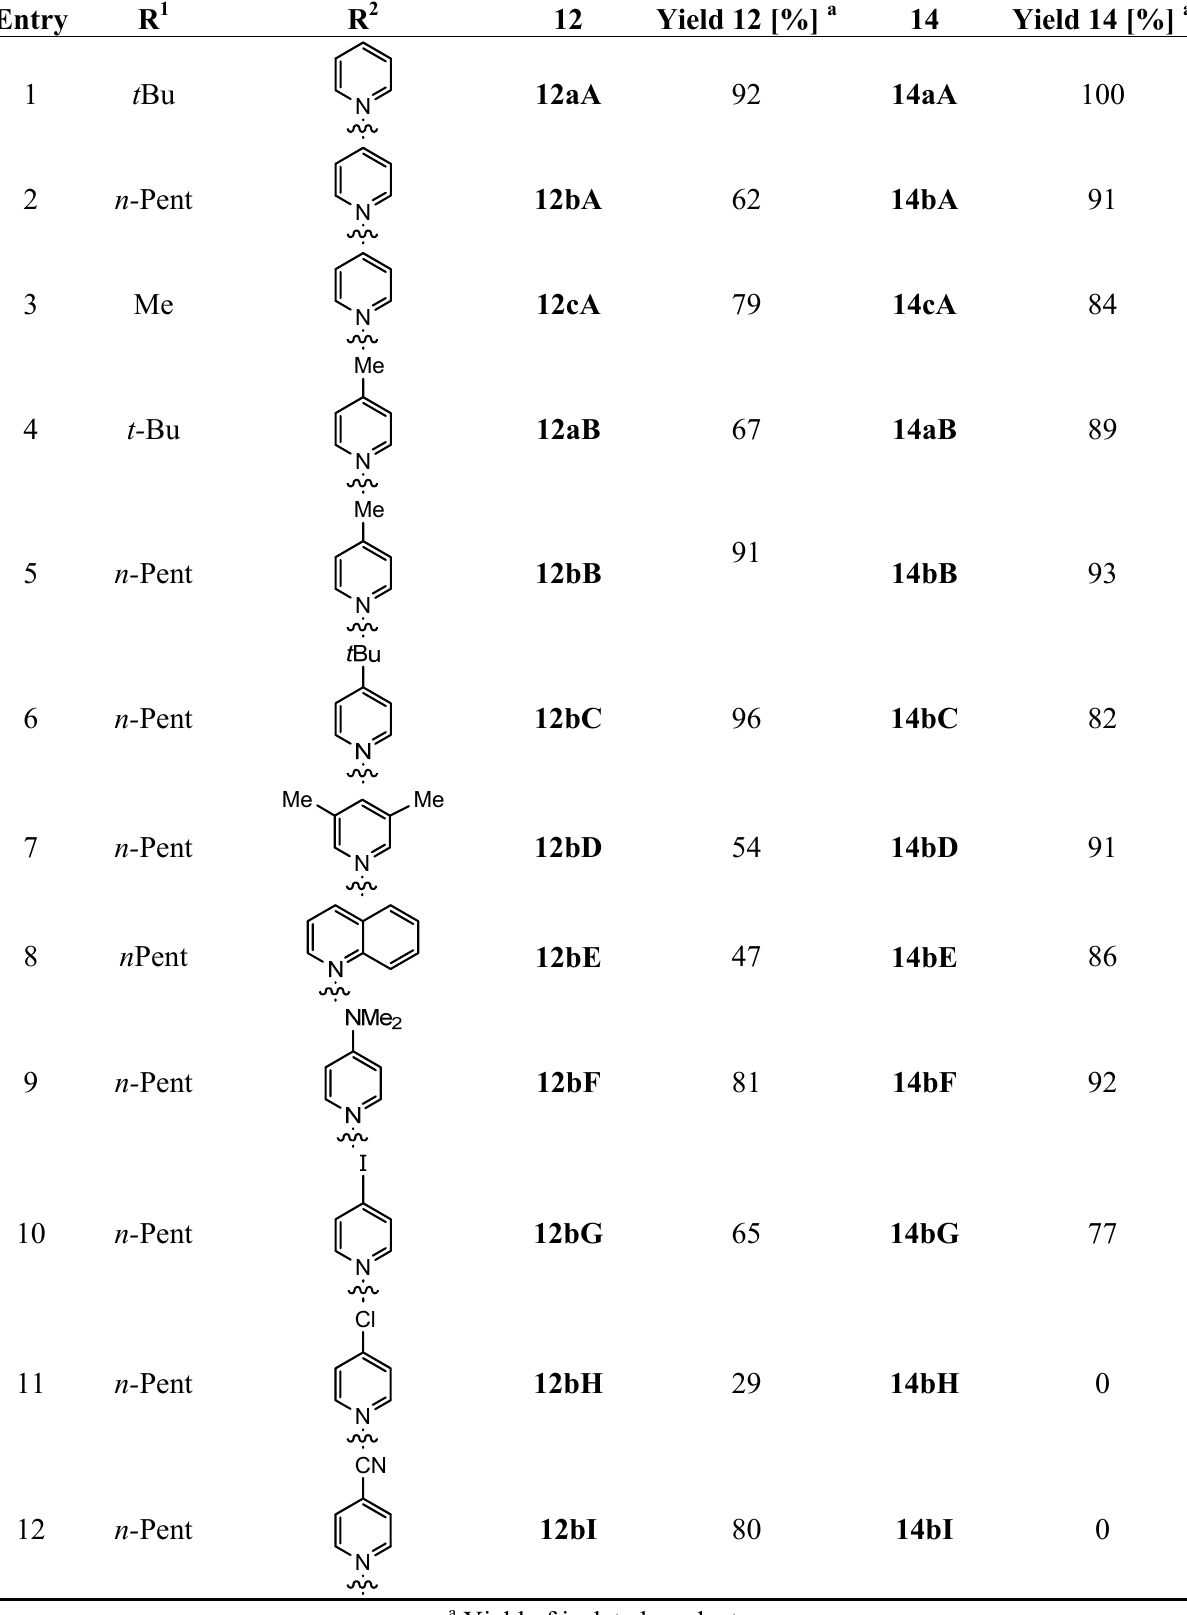
Table 1. Preparation of pyridinium aldehydes 12 and the ionic salen ligands 14